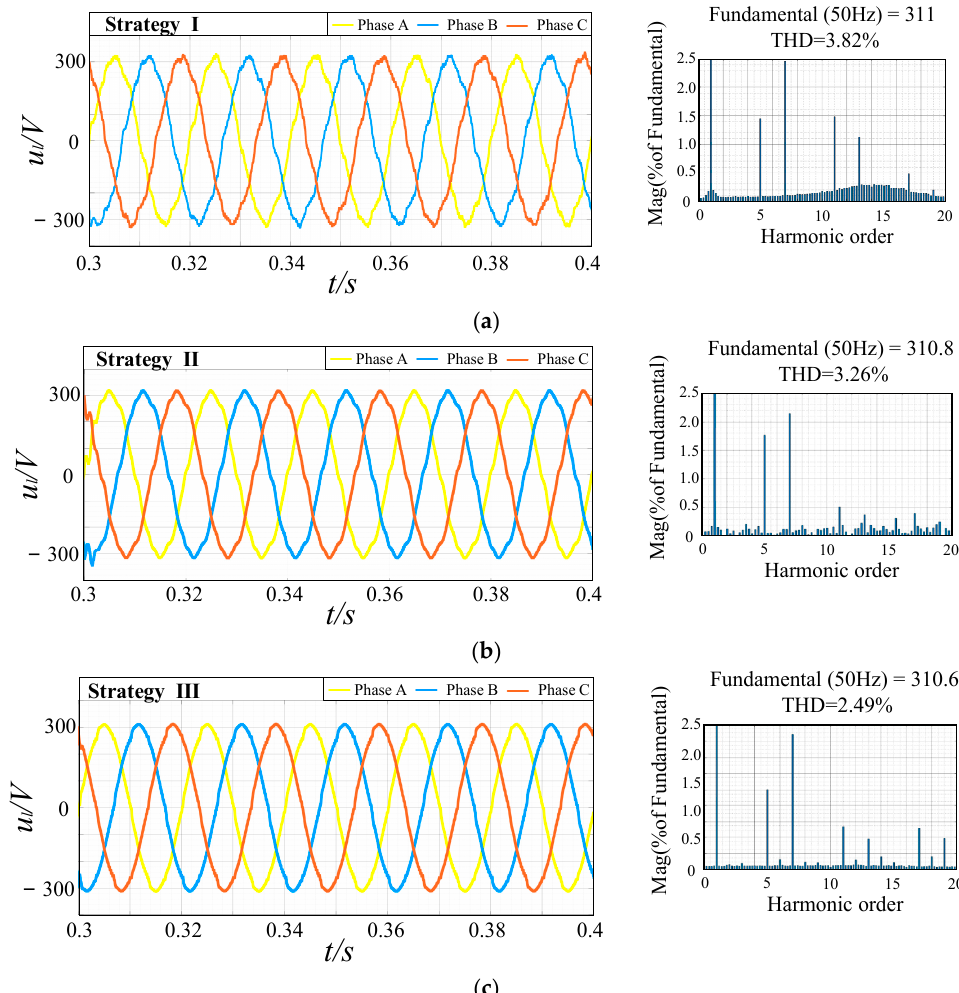
Figure 12. Load voltage after compensation under harmonic conditions. ( a ) Load voltage under Strategy I; ( b ) load voltage under Strategy II; ( c ) load voltage under Strategy III.